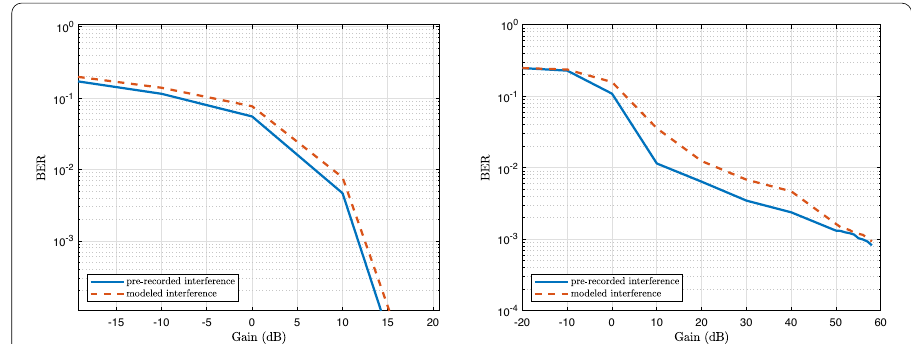
Fig. 11 IQ-based model performance. Left: channel 4, right: channel